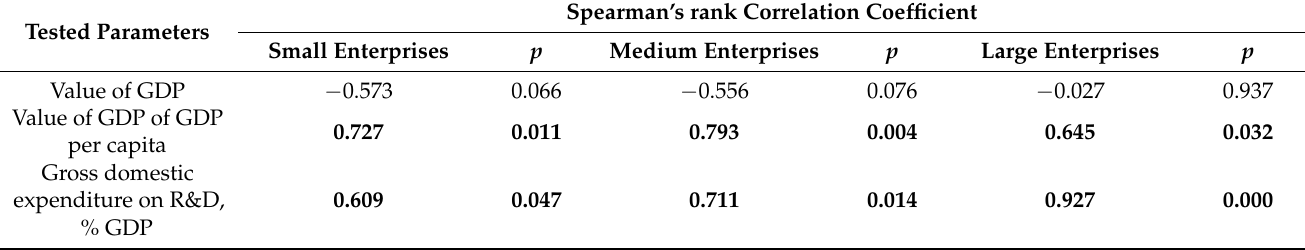
Table 12. Spearman’s rank correlation coefficients between the value of digitalization index of small, medium and large enterprises and the basic economic parameters of CEE countries.